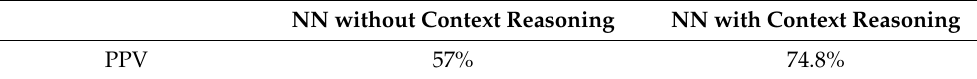
Table 7. NN performance.